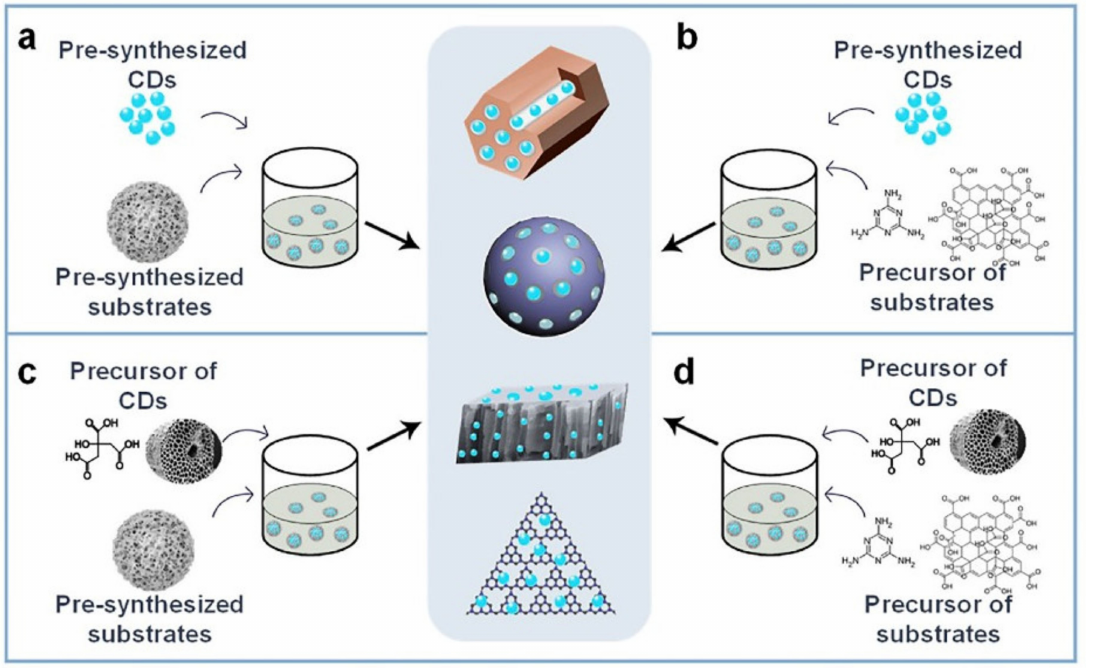
Figure 3. Illustration of CDs composite materials synthesized using different approaches [41]: ( a ) Pre- pare CDs and substrate materials respectively, and then combine them to form CDs composites; ( b ) Prepared CDs as one of the raw materials to prepare the substrate material; ( c ) Add the prepared substrate material to the preparation process of CDs to form CDs; ( d ) One-step method to prepare CDs